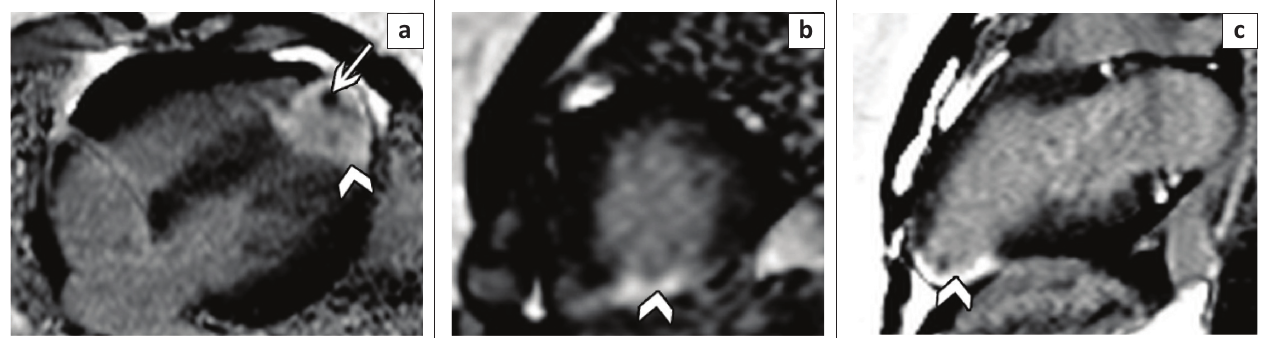
FIGURE 9: Four-chamber (a), short-axis (b) and 2-chamber (c) late gadolinium-enhanced images show a high signal transmural infarction of the LV apex (arrow heads) in an HIV-positive patient with spontaneous coronary artery dissection. The presence of a low signal intensity apical thrombus is also noted (white arrow).